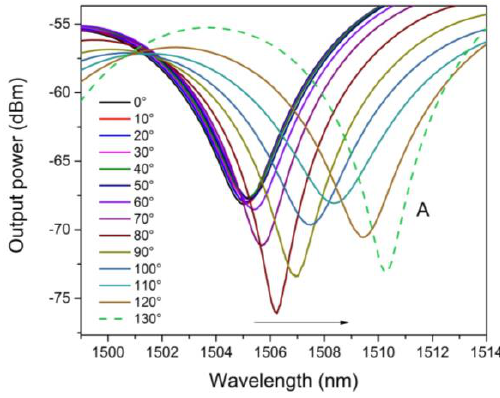
Figure 8. The Interference spectrum to dip centered at 1504 nm.